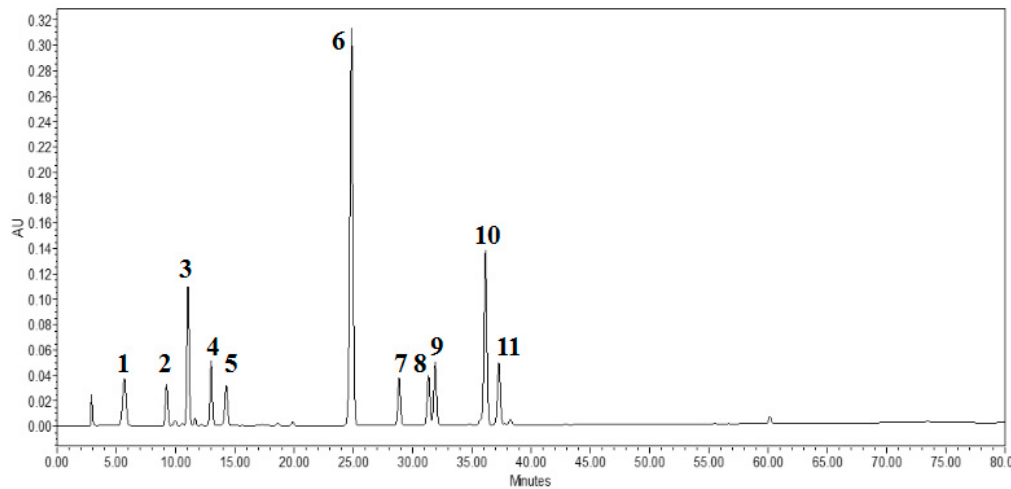
Figure 1. HPLC chromatograms of 11 phenolic compounds in apple fruit (280 nm). Table 4. Identification of chief phenolic compounds in apple